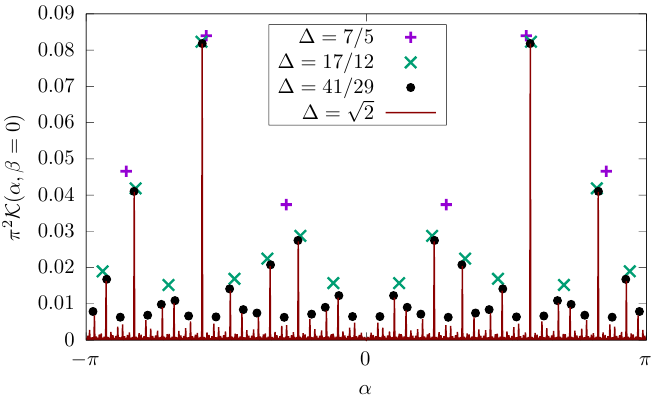
Figure 10: Conjecture (25) for the rescaled correlator (defined in (23)) in the (cid:112) K irrational case, here for ∆ = 2 and θ = π/ 2, and comparison with continued fraction approximations. Notice the fractal-like structure of the graph: sequences of three successive peaks repeat themselves at different scales throughout the